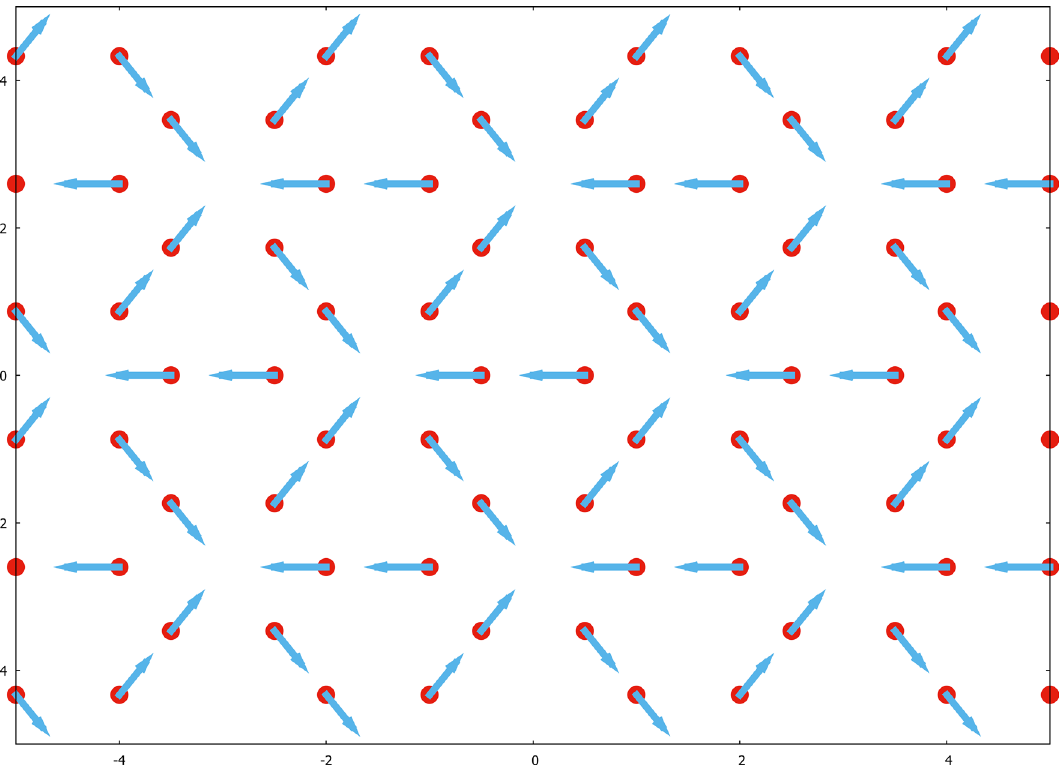
Figure 5. The honeycomb lattice and the corresponding dipole configuration of minimum energy. Notice that every dipole sink coordinates with six local vortices. See text for